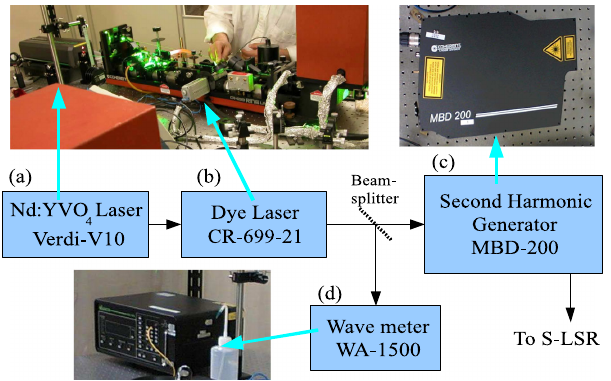
FIG. 3. Main components of the laser system. (a) A solid state laser with the frequency of 532 nm, (b) a 560 nm ring dye laser pumped by the solid state laser, (c) a 280 nm second-harmonic generator using a BBO nonlinear optical crystal and (d) a wavelength meter, which has a precision of 0.01